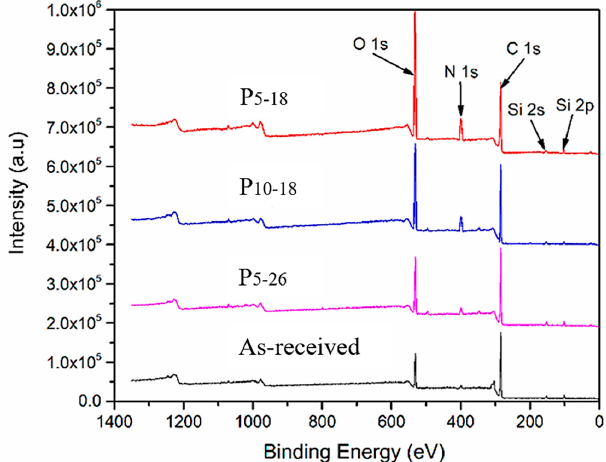
Figure 9. X-ray photoelectron spectroscopy (XPS) spectra showing the effect of plasma treatment process parameters on the surface chemistry of CFRP substrate.